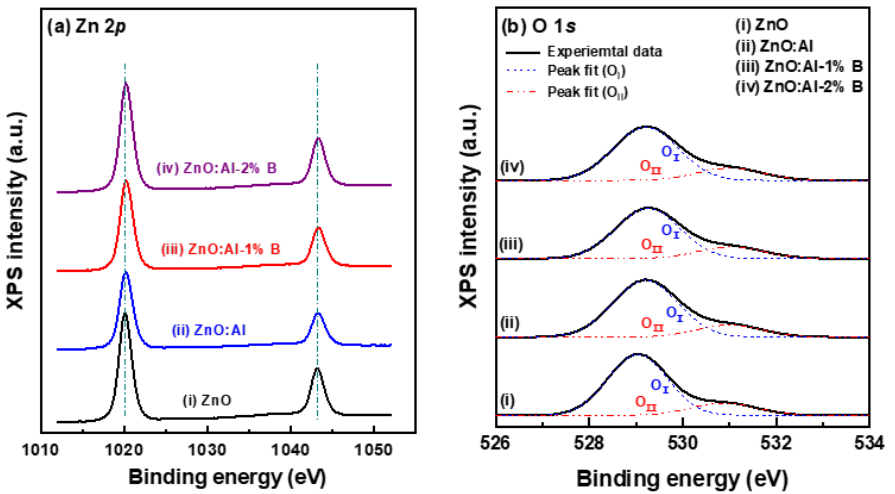
Figure 4. ( a ) Zn 2p narrow scan spectra and ( b ) O 1s narrow scan spectra and the deconvoluted two sub-peaks for the surfaces of the ZnO-based thin films.